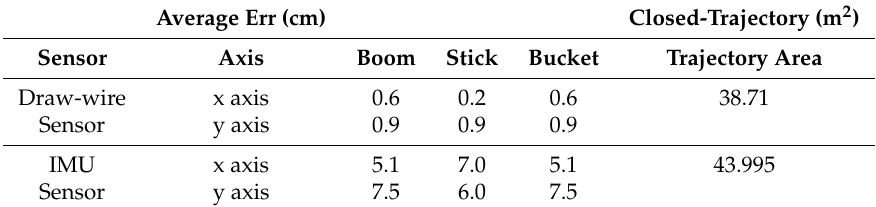
Figure 14. A comparison between the results of the collected data and the reference bucket trajectories. ( A ) Only boom motion; ( B ) Only stick motion; ( C ) Only bucket motion. Table 4. Numerical evaluation when all joints are moving separately or